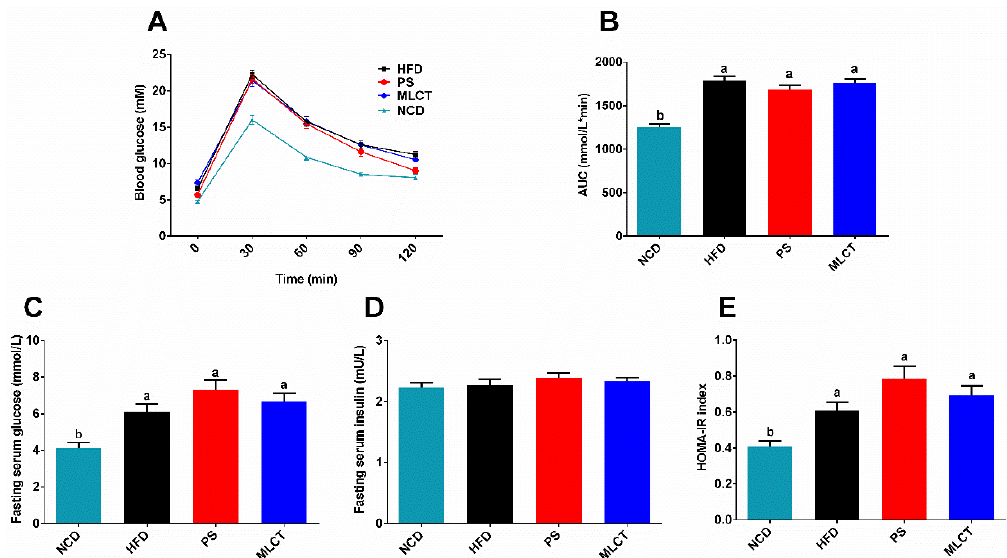
Figure 4. Effects of MLCT on glucose homeostasis. ( A ) Glucose tolerance test (GTT). ( B ) Area under curve (AUC) from GTT. ( C ) Fasting serum glucose. ( D ) Fasting serum insulin. ( E ) HOMA-IR. Data were shown as mean ± SE ( n = 8). In ( B , C , E ), means with the different lowercased letters differ significantly ( p < 0.05) according to one-way ANOVA analysis followed by Tukey’s